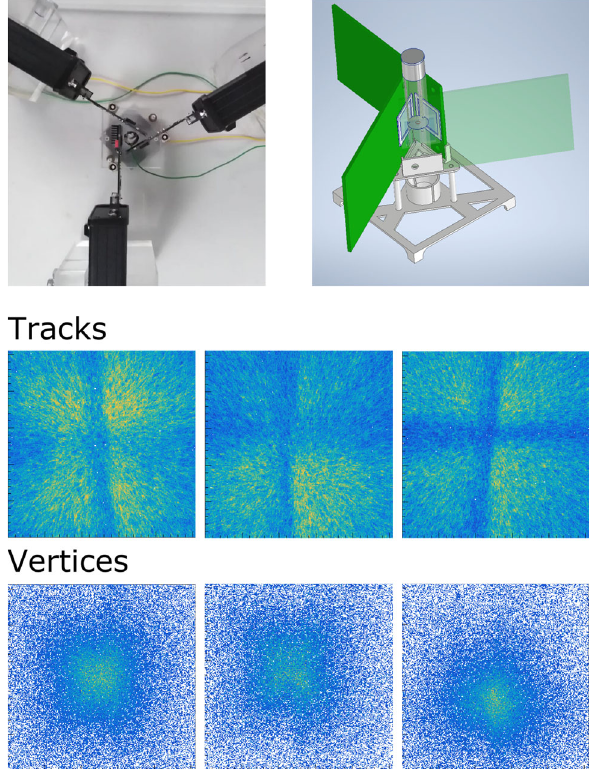
Fig. 11 Top: A triangle of TPX3 detectors surrounding a target, used to test performance of the detectors. Middle: Tracks detected in each of thethreeTPX3detectors.Bottom:Reconstructionofthereactionvertex